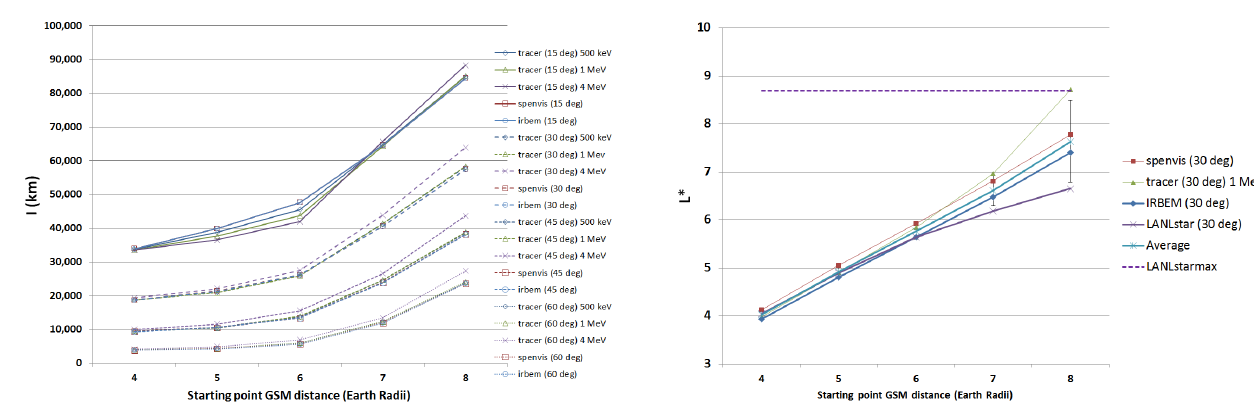
Figure 4. Calculations of L ∗ as a function of initial distance (in R E ) at 00:00MLT, for an initial pitch angle of 30 ◦ during quiet solar wind conditions. Error bars represent the standard deviation between results from the various models.